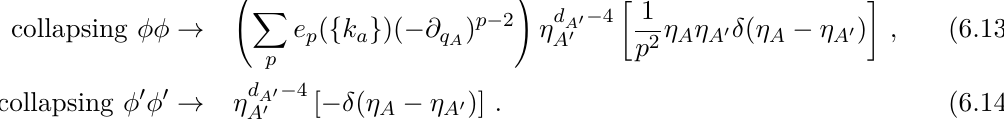
Figure 10 . Expansion for vertices of type 1 The first term in the expansion denotes a sum over half-edges Am , namely the part of edge m ending on the vertex A , where that half-edge becomes a φ 0 . In the second term all half-edges are of the φ -type, corresponding to the ordinary massless mode